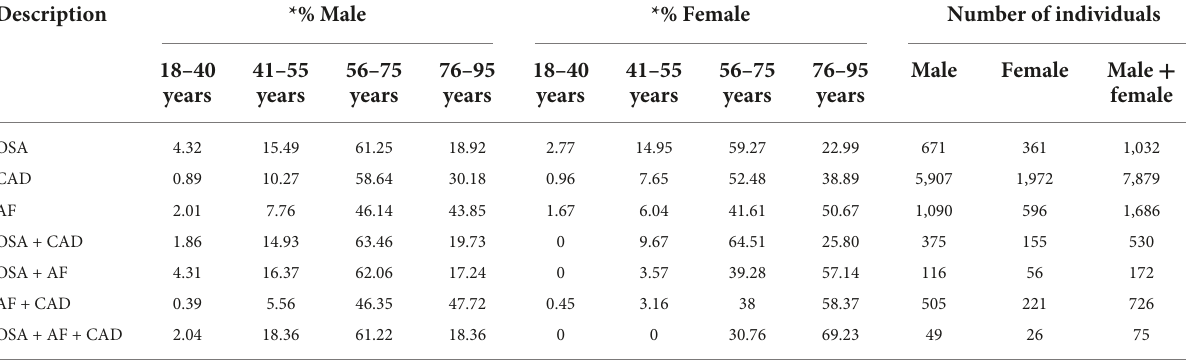
TABLE 2 Prevalence of AF, OSA, and CAD in groups classified by sex and